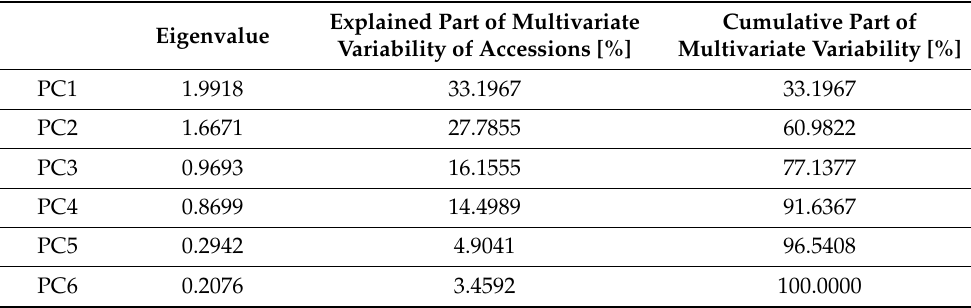
Table 5. Eigenvalues and values of the explained variance for the model from the Penicillium sp. license.